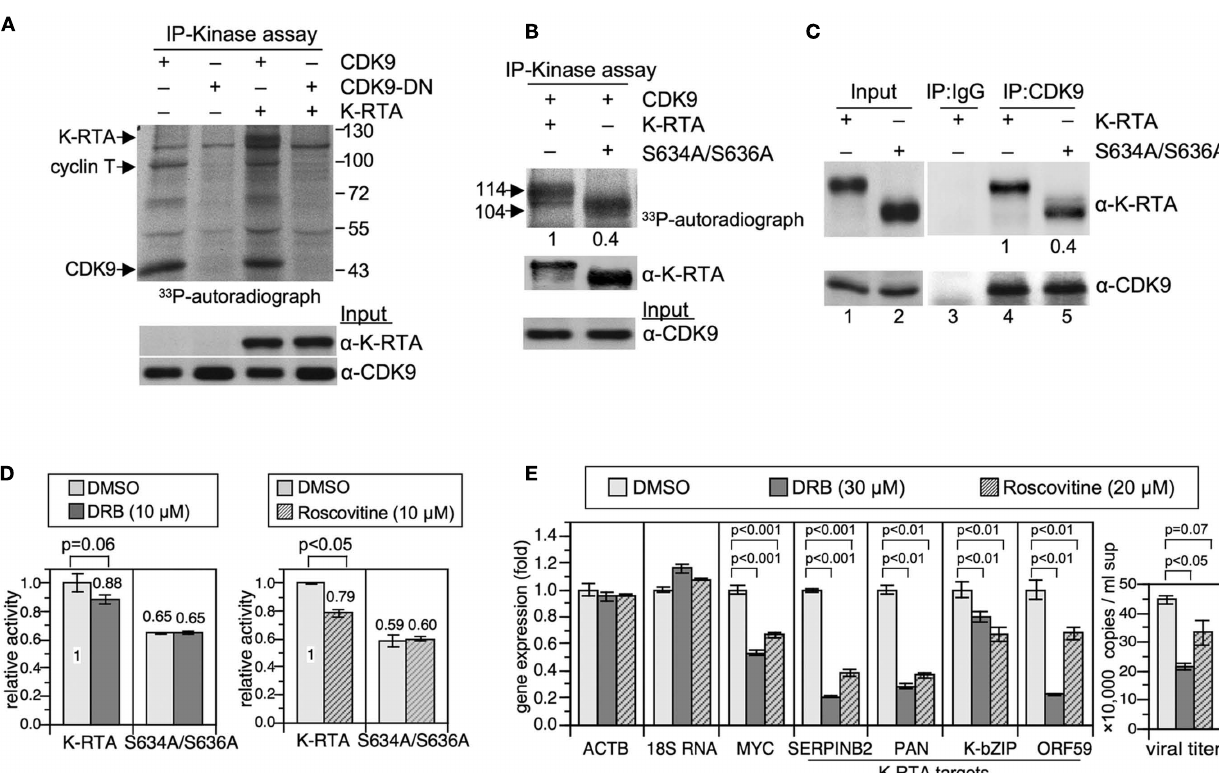
FIGURE 5 | CDK9 phosphorylated K-RTA in vitro and CDK9 associated with K-RTA in vivo . (A) Protein extracts of 293T cells expressing indicated plasmids were harvested and subjected to immunoprecipitation (IP)-kinase assay using M2 FLAG affinity resin.The resulting mixtures were resolved by 8% SDS-PAGE and revealed by autoradiography. A distinct 114kDa band is detected only when both K-RTA and CDK9 are present, indicating that K-RTA is a CDK9 substrate. CDK9-DN, CDK9 dominant negative. (B) Quantitation of CDK9 activities toward K-RTA vs. S634A/S636A.The band intensity in the autoradiograph film was normalized with the band intensity in α -K-RTA followed by setting K-RTA’s value to be 1. Although more S634A/S636A was captured in the immunocomplex, only 40% γ - 33 P-ATP was labeled onto S634A/S636A relative to that in K-RTA, suggesting that wild type K-RTA is a better substrate for CDK9. (C) Phosphorylation of Ser-634 and Ser-636 may play a role in CDK9 recruitment. Association of K-RTA and S634A/S636A with cellular CDK9 was determined by IP-Western blot analysis using α -CDK9 bounded Dynabeads-protein G. After normalized with the input proteins (lanes 1 and 2), S634A/S636A only retained 40% in CDK9 association ability, suggesting that Ser-634 ad Ser-636 are involved in CDK9 recruitment. (D) The effects of DRB (5,6-dichloro-1-beta-d- ribofuranosylbenzimidazole) and roscovitine on K-RTA-mediated